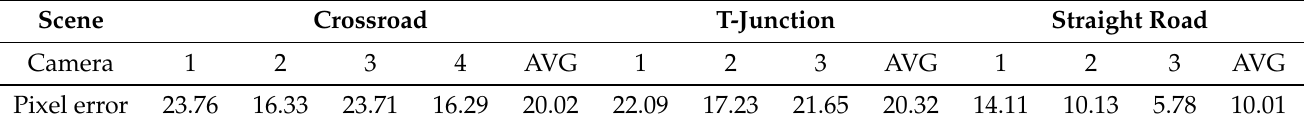
Table 3. The pixel error of different monitoring